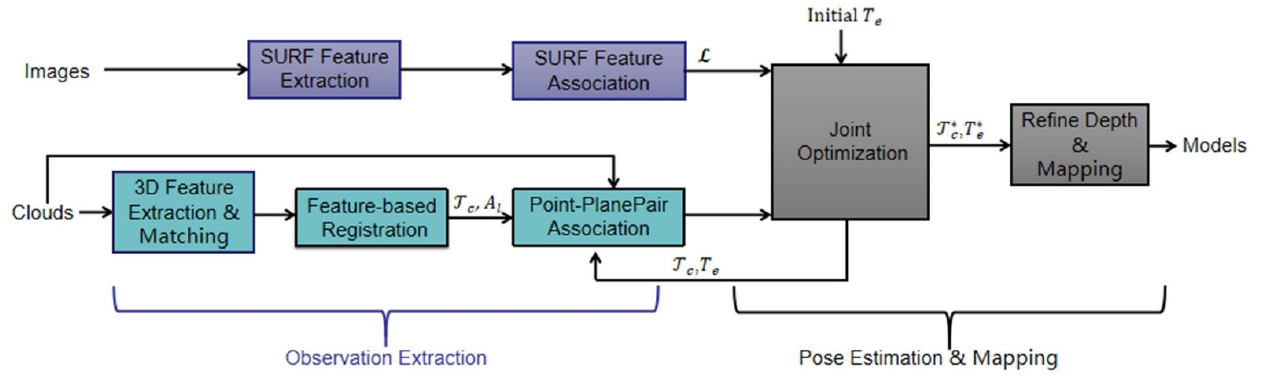
Figure 8. A diagram of the LiDAR–camera fusion method for accurate dense 3D reconstruction system pipeline; scheme modified for this study from [123].